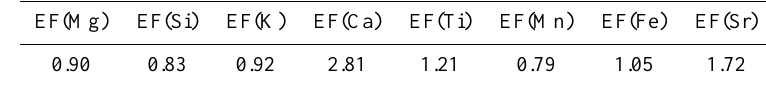
Table 3. Enrichment factors for the mineral dust source.